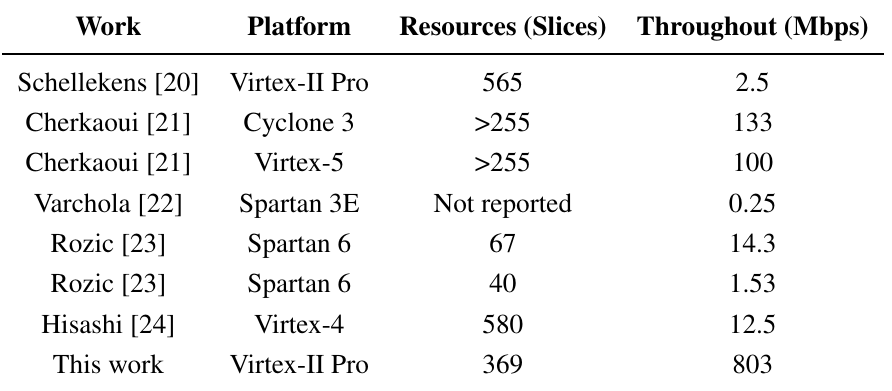
Table 2. Comparison of related